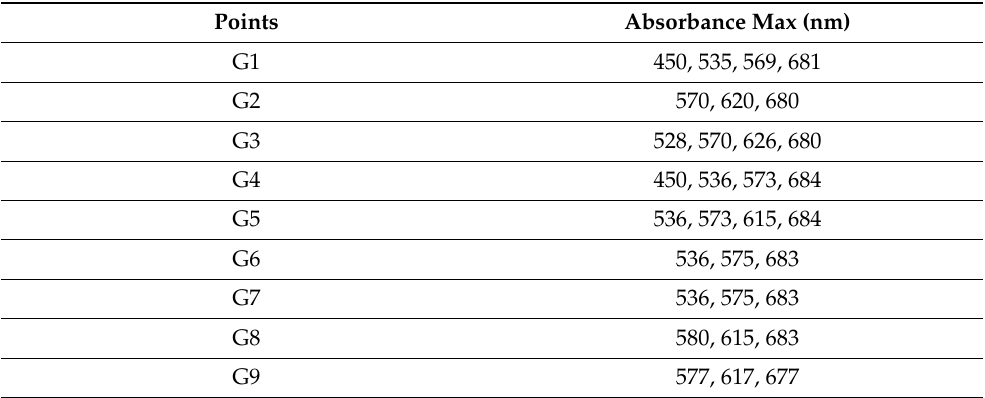
Table 3. Absorption maxima of the points chosen from Paolo Gioli’s original artwork obtained by FORS